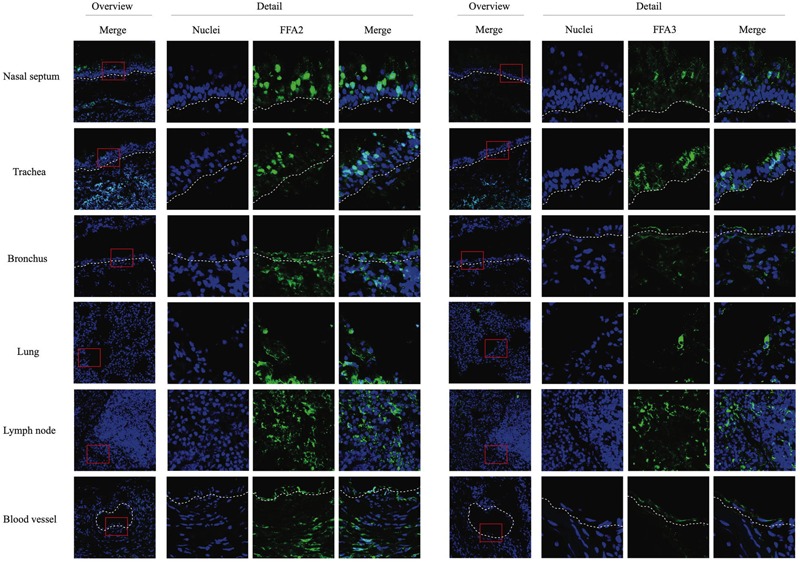
Immunofluorescence staining of the two main SCFA receptors, FFA2 (left panel) and FFA3 (right panel) in respiratory and lymph nodal tissues isolated from healthy horses. After collection, tissues were snap-frozen in liquid nitrogen. Both receptors were stained in green (FITC), nuclei were counterstained in blue (Hoechst).